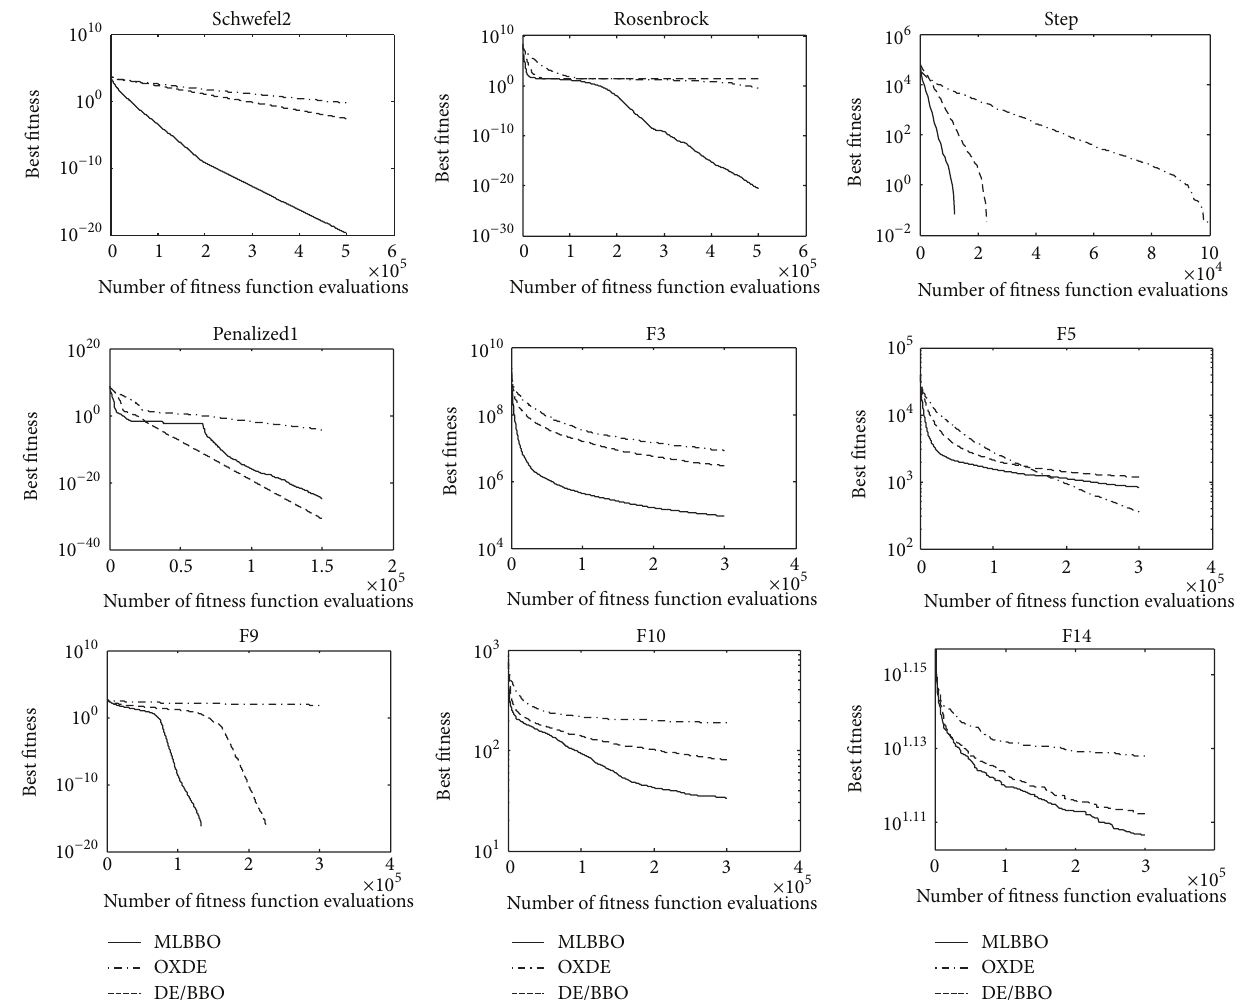
Figure 5: Convergence curves of mean fitness values of MLBBO, OXDE, and DE/BBO for functions f3, f5, f6, f12, F3, F5, F9, F10, and